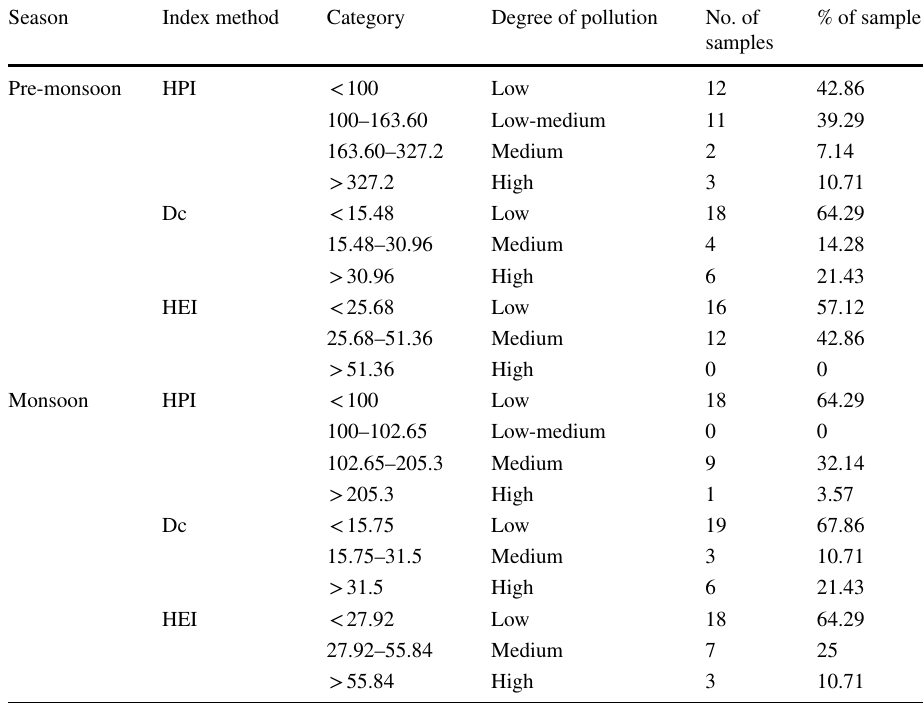
Table 6 Water Quality Rating based on Mean Based Reclassification Methods including HPI, Dc, and HEI in Pre-monsoon and Monsoon